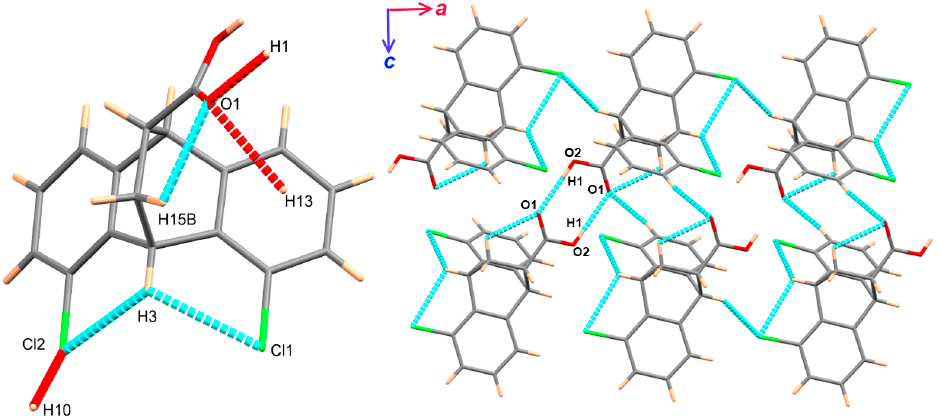
Figure 2. Hydrogen bond contacts ( left ) and packing of molecular units via hydrogen bonding interactions ( right ).